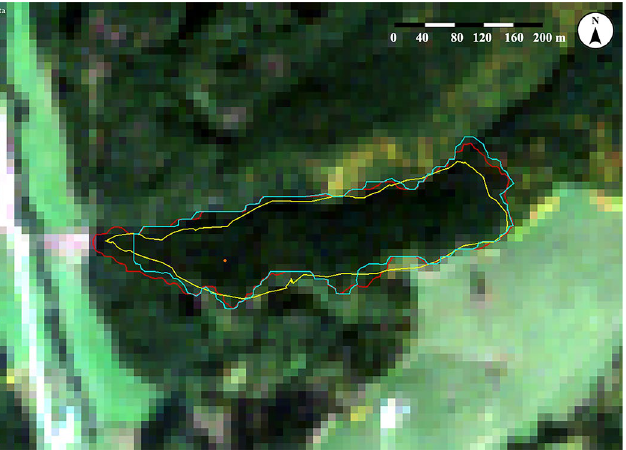
Figure 9. Visual comparison of three curves, GPS track (yellow), semiautomatic segmentation (red), and automatic segmentation (turquoise), for the segment of planted spruce forest, relevé 769,205 (created in software NaturaSat v1.2 31 , October 17, 2019; acquisition time 9:40:29, spatial resolution of Sentinel-2 satellite image is 10 m, 1 pixel on the satellite image represents 10 × 10 m on the Earth